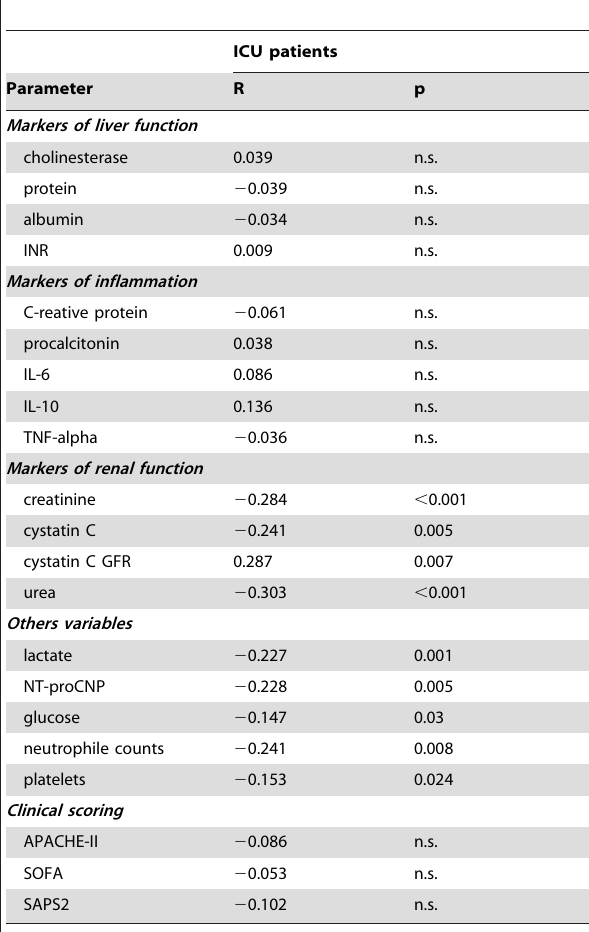
Table 3. Correlations of miR-150 serum concentrations at ICU admission with other laboratory